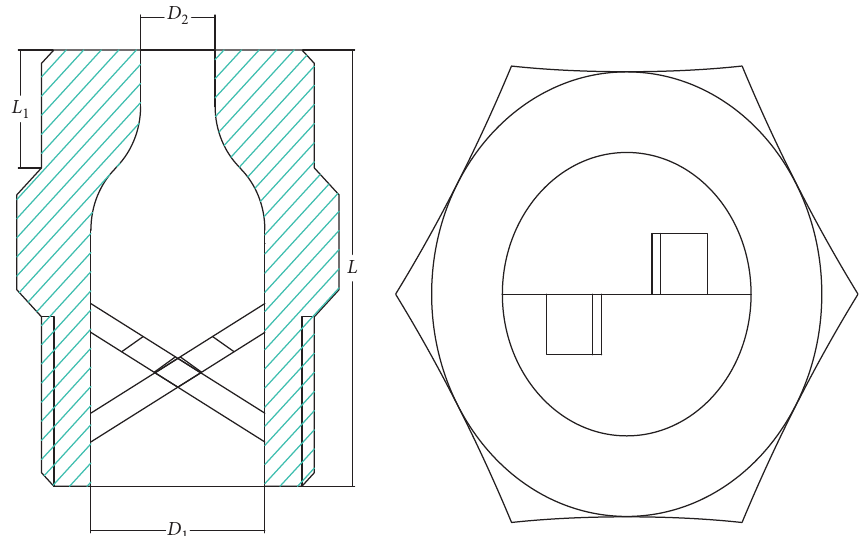
Figure 1: Diagram of swirl nozzle structure.